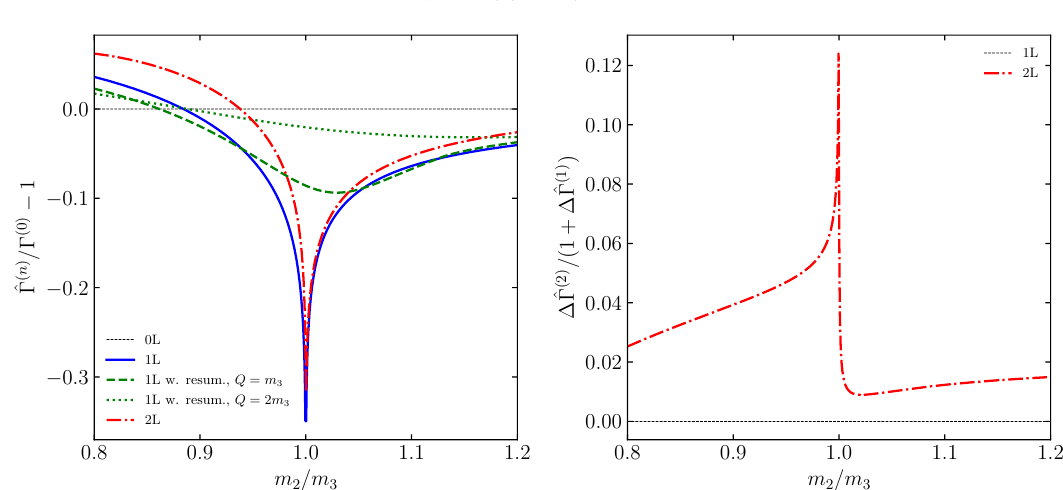
Figure 8. One- and two-loop external φ 3 leg corrections to the φ 3 → χ ¯ χ decay width in the toy model of section 2 as a function of the ratio m 2 /m 3 . In the left plot the one-loop result with and without resummation of the φ 1 contributions (with different choices of the renormalisation scale Q ) and the two-loop result for the decay width are shown relative to the tree-level result, while in the right plot the two-loop corrections are shown relative to the one-loop result. The parameters are m 3 = 500 GeV, m χ = 200 GeV, λ 1122 = 1 , λ 1133 = 1 . 2 , and A 123 = 1500 GeV. An MS renormalisation scheme is employed for A 123 in the two-loop decay width